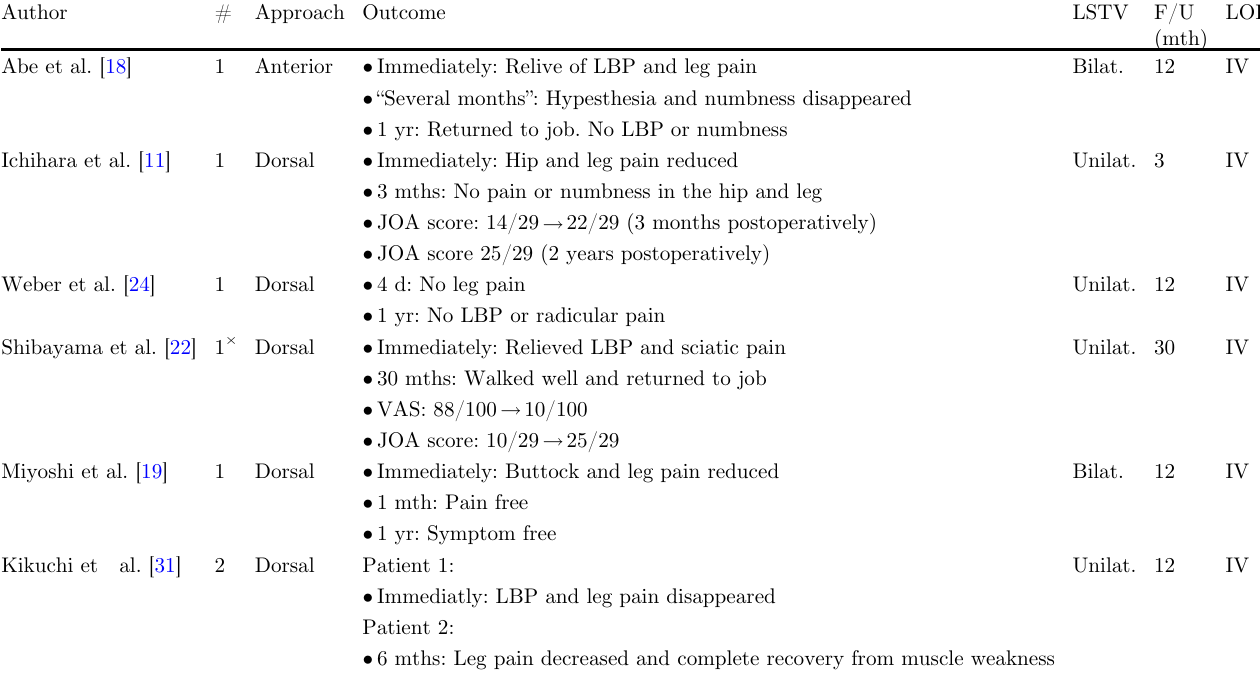
Table 4. Surgical nerve